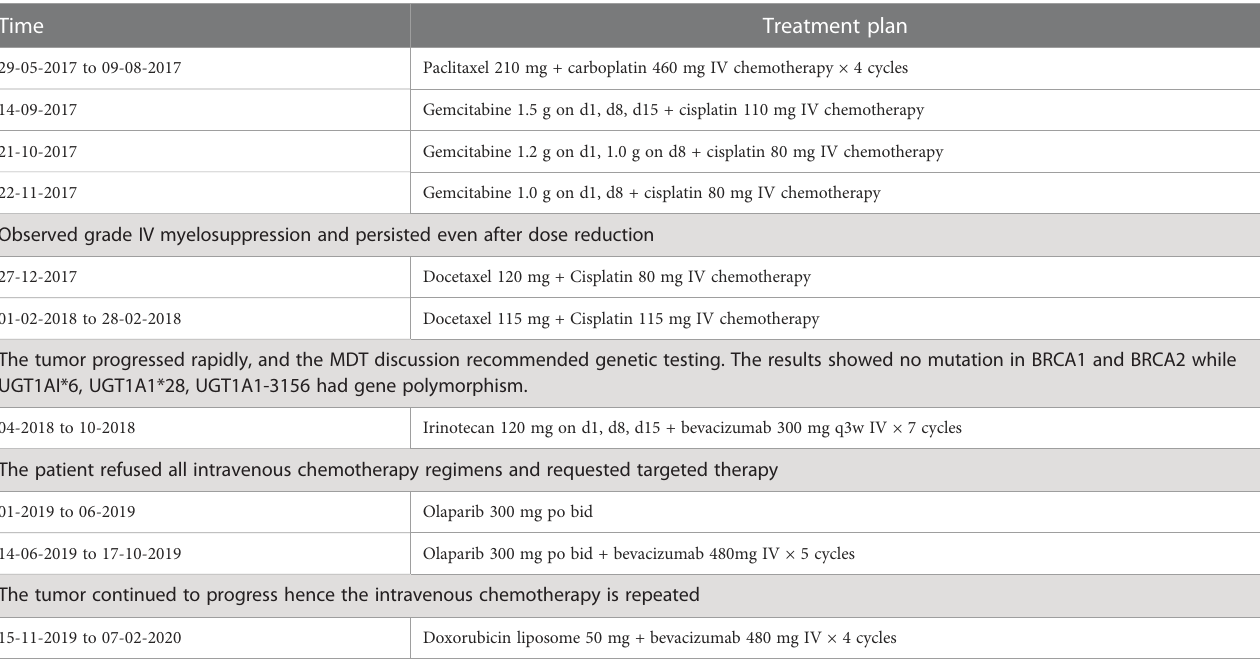
TABLE 1 Different treatment regimens followed throughout the study. Time Treatment